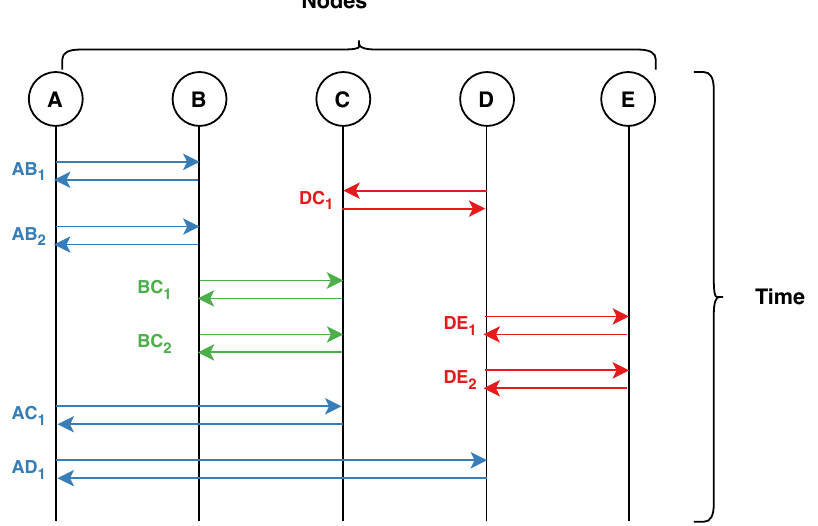
Figure 2. Flow aggregation of network traffic flows. Each colour represents an aggregated